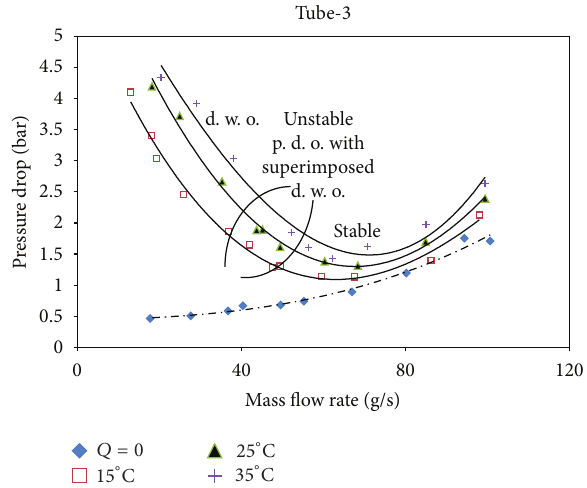
F 6: e steady state characteristic curves for